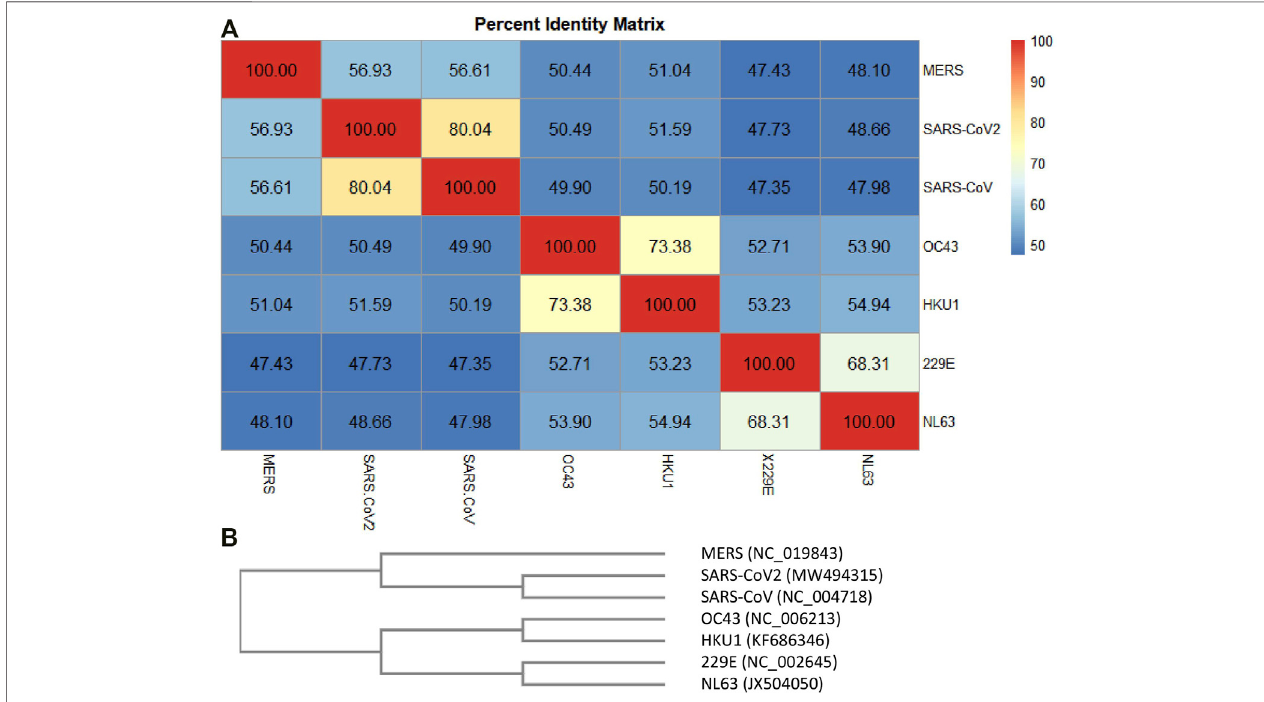
FIGURE4| Percentidentitymatrix.In (A) ,thepercentidentitymatrixisreported,whichshowsthe%ofidentitiesamongtheHCoVs.In (B) ,thesimilarityphylogram tree is shown. The branch length is proportional to the number of nucleotide substitutions, that is, to the number of evolutionary events that took place after the branching